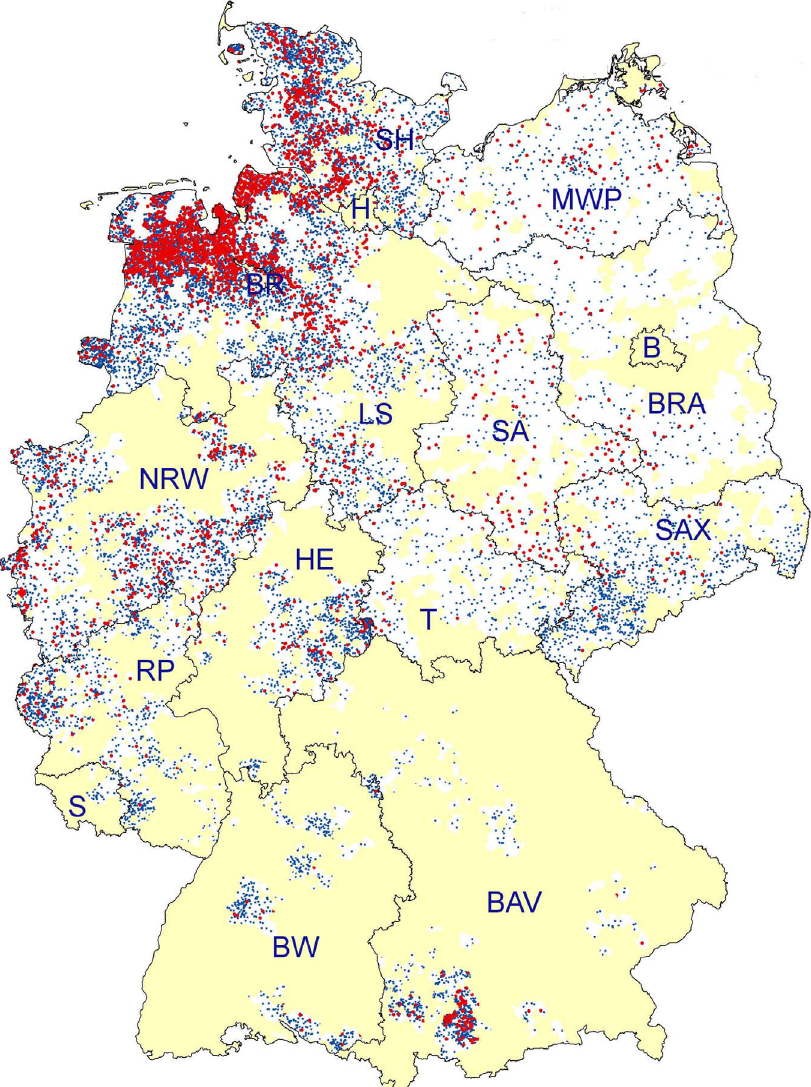
Figure 2. Distribution of D.viviparus BTM ELISA positive (red dots) and negative (blue dots) dairy herds throughout the sampled regions of Germany. Dots for BTM-positive and -negative dairy herds were randomly distributed within the respective postal code area. The white colour marks sampled postal code areas, while the yellow colour marks postal code areas which were not sampled. Federal states are abbreviated as follows: B=Berlin, BAV=Bavaria, BR=Bremen; BRA=Brandenburg, BW=Baden-Wu¨rttemberg, H=Hamburg, HE=Hesse, LS=Lower Saxony, MWP=Mecklenburg-Western Pomerania, NRW=North Rhine-Westphalia, RP=Rhineland-Palatinate, S=Saarland, SA=Saxony-Anhalt, SAX=Saxony, SH=Schleswig-Holstein,